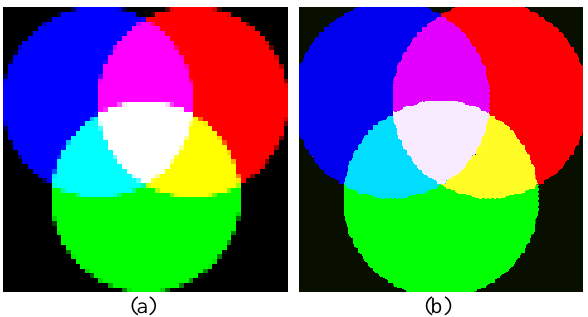
Figure 6. Evaluation of the proposed SRM method on simulated simple geometric shape: (a) degraded image, (b) finer spatial resolution image produced by the SRM algorithm ( Z=5, M=8 ).